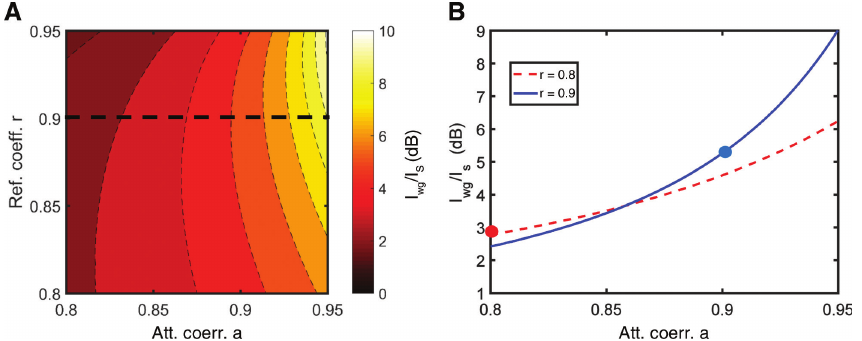
Figure 3: (A) Output waveguide coupled intensity as a function of reflection r and attenuation a coefficients. (B) Waveguide coupled intensity at fixed values of r = 0.8 and r = 0.9. The dot on each curve marks the critical coupling condition. For a fixed value of r , higher coupled intensities are obtained for low loss resonators ( a → 1) disregarding the critical coupling condition.